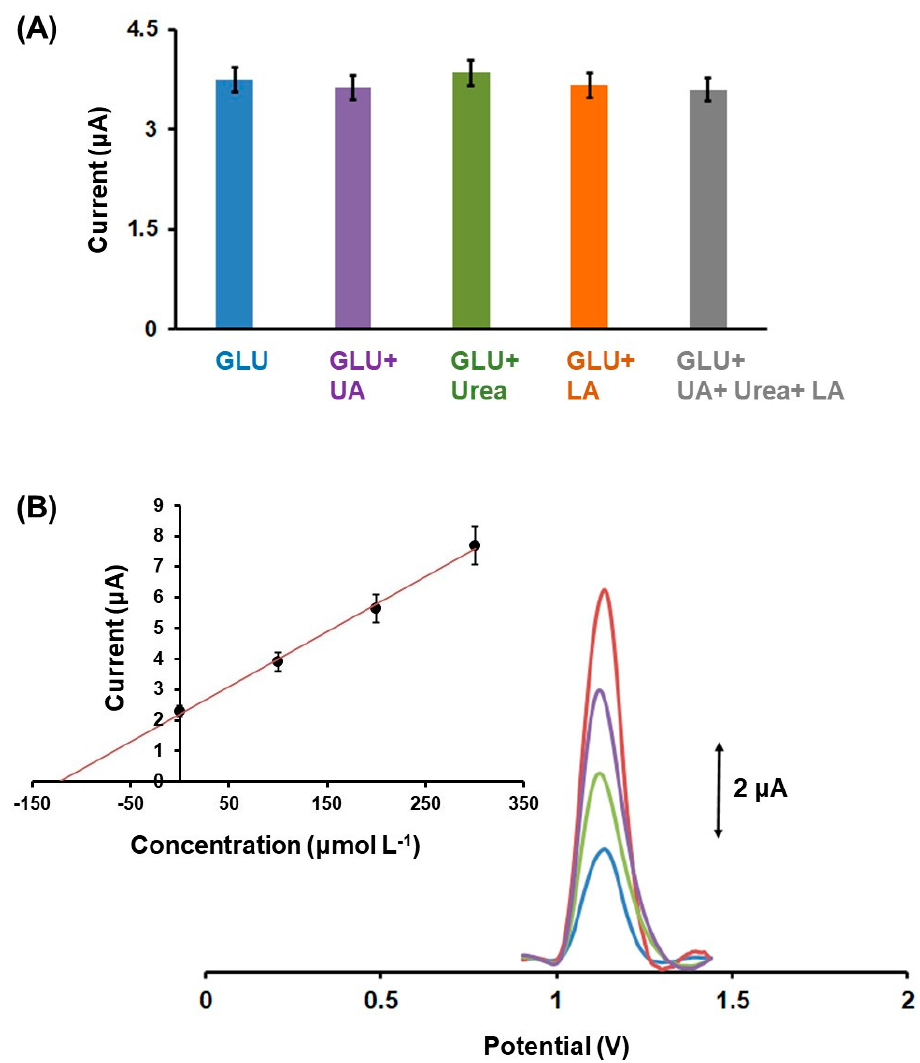
Figure 8. ( A ) Effect of different biomarkers presented in sweat on the DPV peak height of 200 μ mol 200 µ mol L − 1 GLU at the Fe 3 O(PhCO 2 ) 6 (H 2 O) 3 ] · PhCO 2 /3DPE, where: (blue bar) 200 µ mol L − 1 L − 1 GLU at the Fe 3 O(PhCO 2 ) 6 (H 2 O) 3 ] ∙ PhCO 2 /3DPE, where: (blue bar) 200 μ mol L − 1 GLU in artificial GLU in artificial sweat (AS); (purple bar) 200 µ mol L − 1 GLU + 250 µ mol L − 1 UA in AS; (green bar) sweat (AS); (purple bar) 200 μ mol L − 1 GLU + 250 μ mol L − 1 UA in AS; (green bar) 200 μ mol L − 1 GLU 200 µ mol L − 1 GLU + 220 mmol L − 1 urea in AS; (orange bar) 200 µ mol L − 1 GLU + 55 mmol L − 1 + 220 mmol L − 1 urea in AS; (orange bar) 200 μ mol L − 1 GLU + 55 mmol L − 1 lactic acid (LA) in AS; (grey lactic acid (LA) in AS; (grey bar) 200 µ mol L − 1 GLU + 250 µ mol L − 1 UA + 220 mmol L − 1 bar) 200 μ mol L − 1 GLU + 250 μ mol L − 1 UA + 220 mmol L − 1 urea + 55 mmol L − 1 lactic acid in AS. ( B ) urea + 55 mmol L − 1 lactic acid in AS. ( B ) DPV responses and respective plot for the